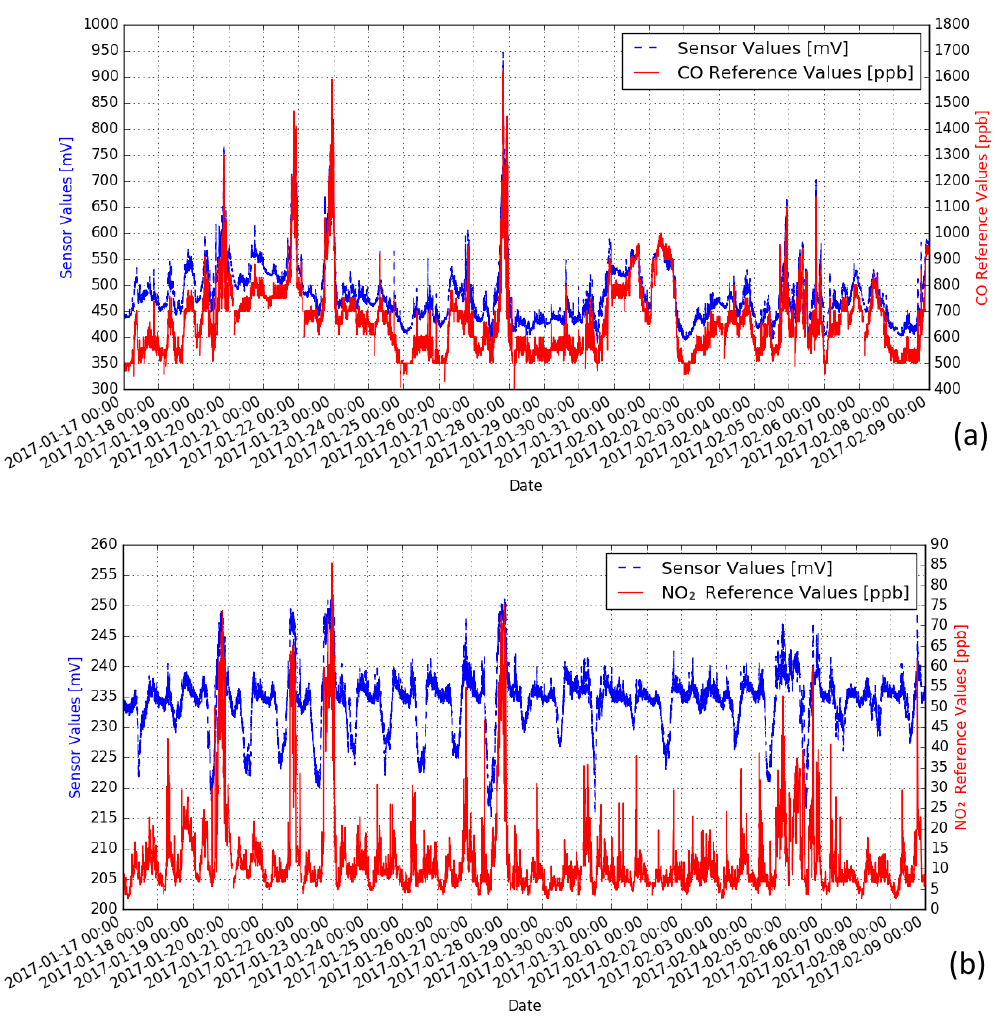
Figure A3. Line plots of sensor values from CO and NO 2 Sensor-Modules, and reference values from EPD’s station. ( a ) CO data pairs; ( b ) NO 2 data pairs.